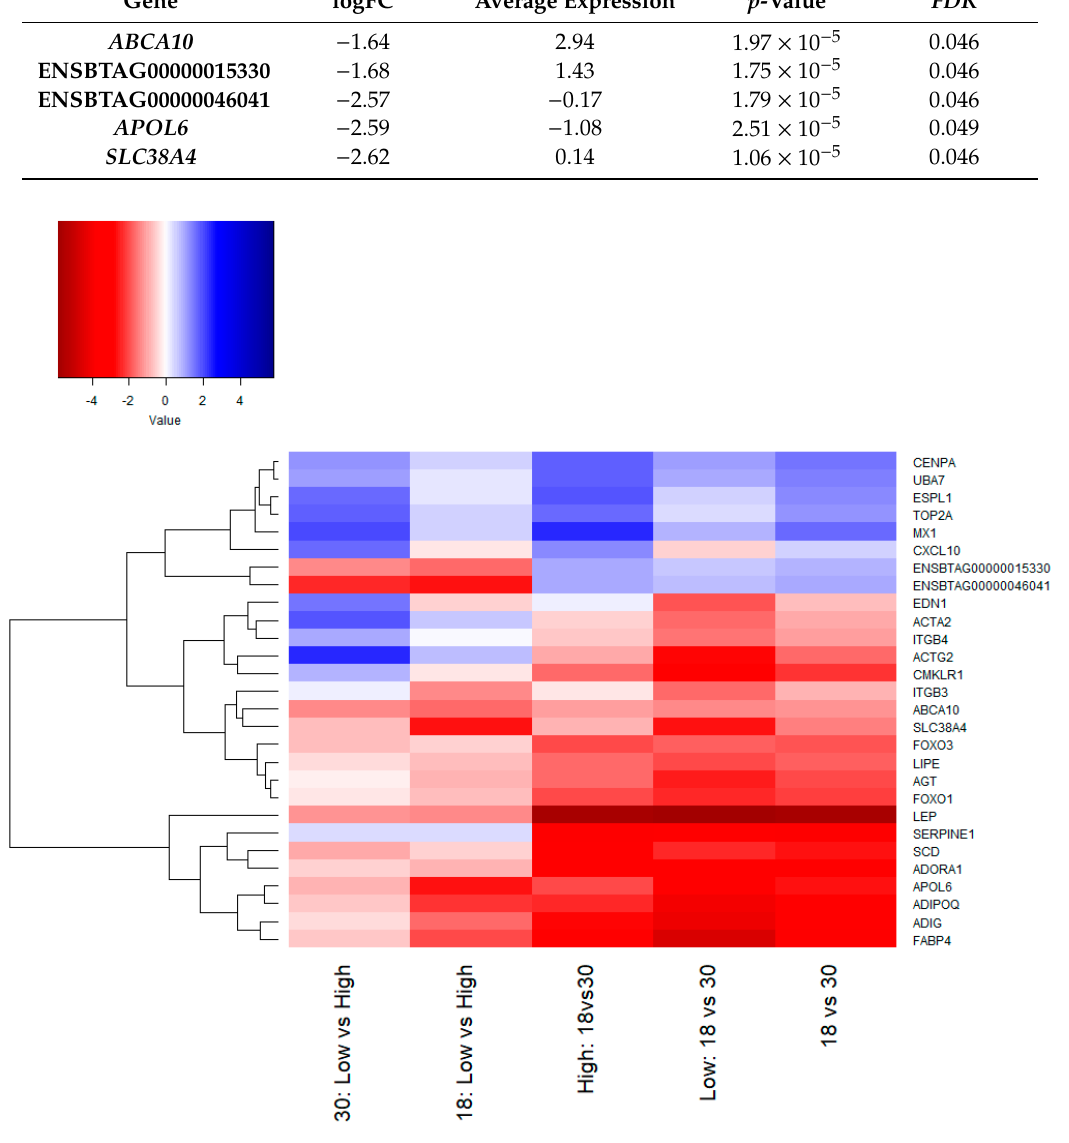
Figure 3. Heatmap comparing the differentially expressed genes. The values shown are the logarithmic fold change (logFC) obtained for each contrast. Table 2. Differentially expressed genes in Hanwoo steers at 18 months old. Gene.